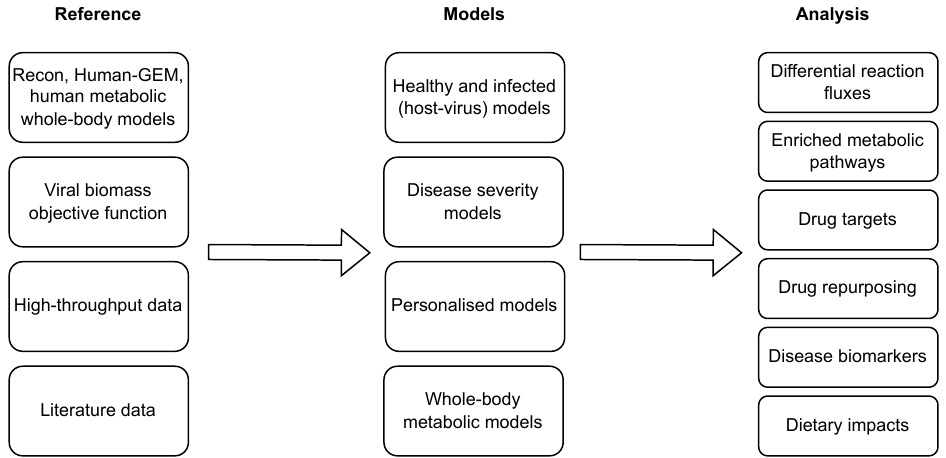
Figure 4. Reconstruction and analysis of COVID-19-specific GEMs. Recon models, Human–GEM and human metabolic whole-body models (WBMs) have been applied as reference models in combination with different forms of viral biomass objective function (VBOF), high-throughput data, and literature data. The reconstruction approaches have focused on establishing group-specific, or even person-